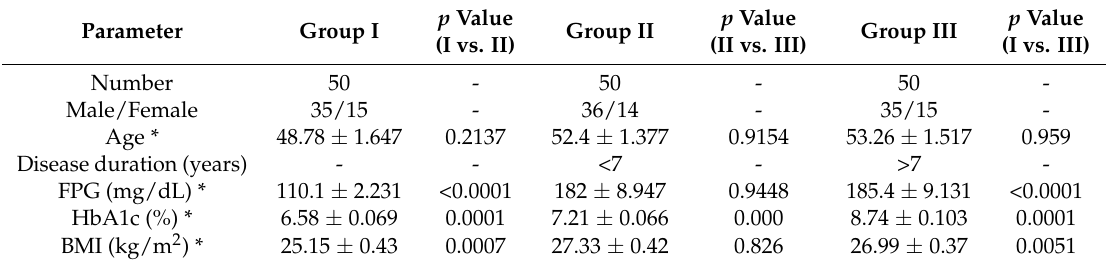
Table 1. General features of the subjects.